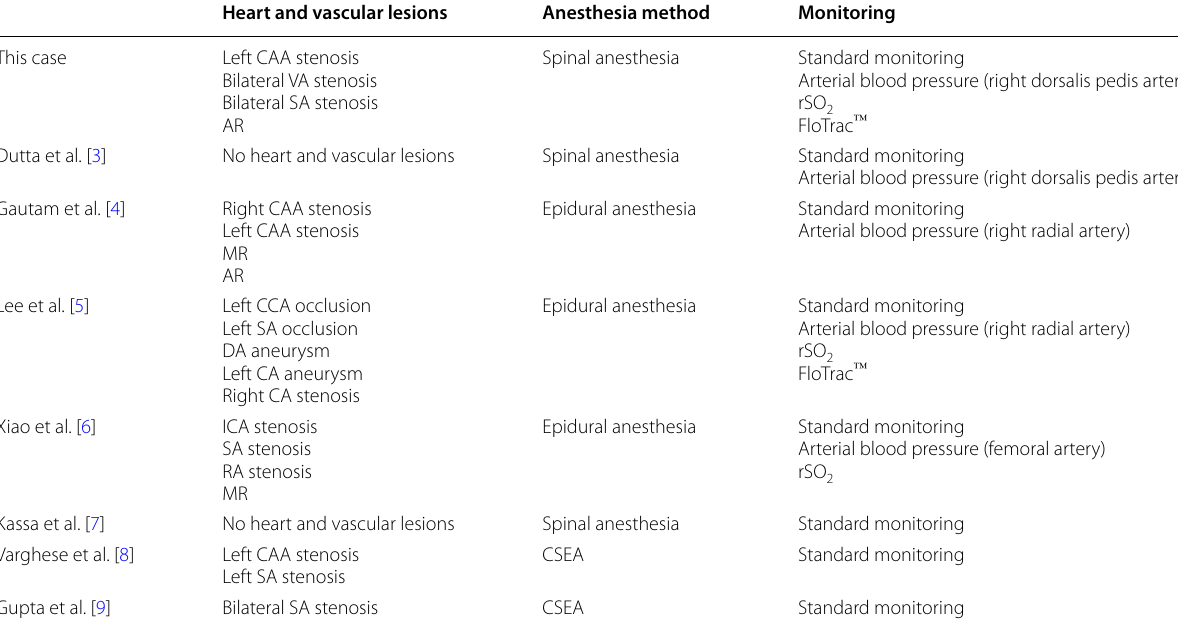
Table 1 Past anesthetic management of cesarean section in patients with Takayasu’s arteritis